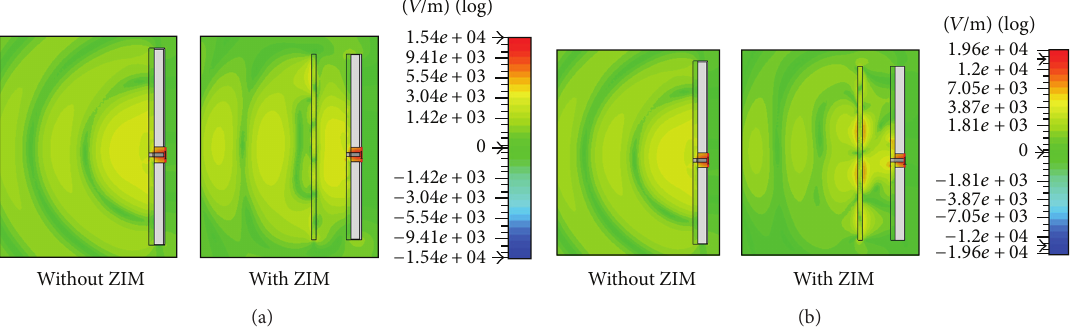
Figure 13: The comparative electric field magnitude distributions of the antennas, (a) 10GHz and (b) 11.1GHz.